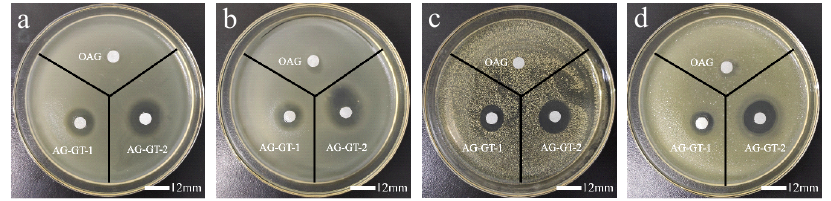
Figure 3. Inhibition zone of E. coli treated with sample solutions at a concentration of 5 mg/mL ( a ) and 10 mg/mL ( b ); inhibition zone of S. aureus treated with sample solutions at a concentration of 5 mg/mL ( c ) and 10 mg/mL ( d ).